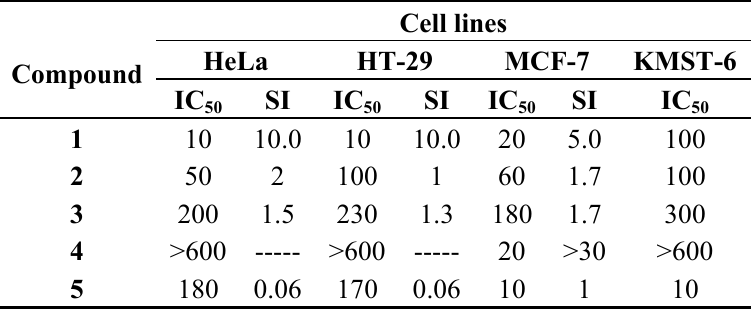
( μ M) values for compounds 1 – 5 as determined by WST-1 Table 2. IC 50